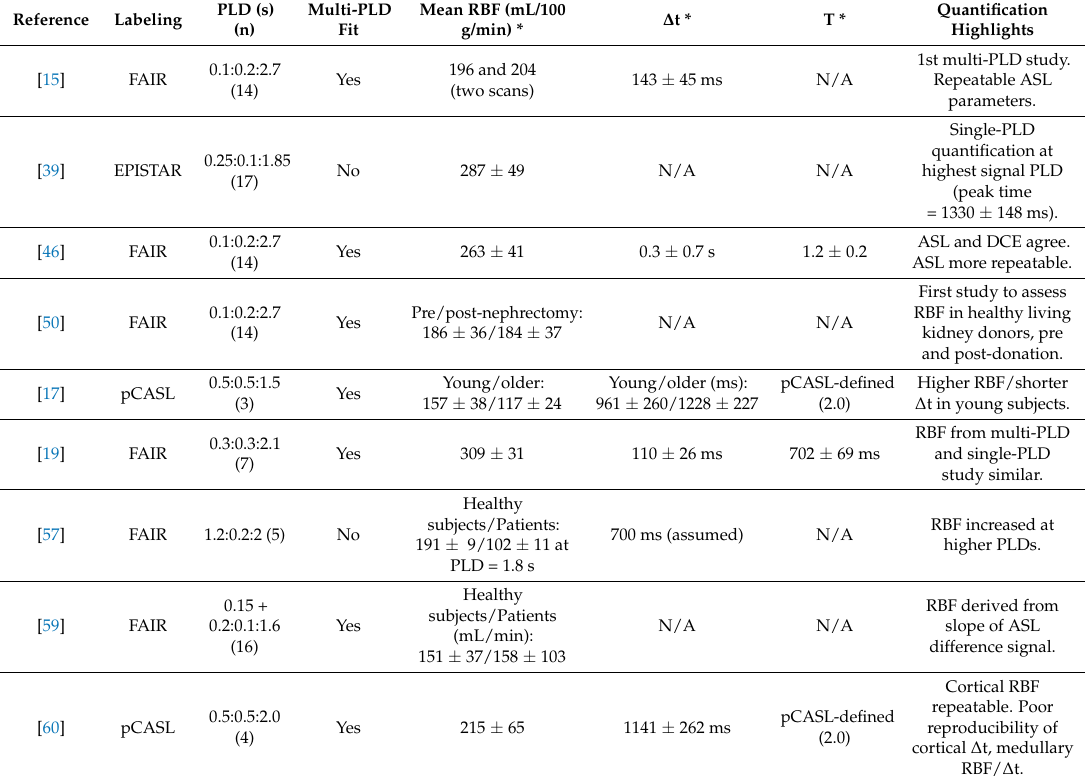
Table 4. Overview of renal ASL studies using multiple post-labeling